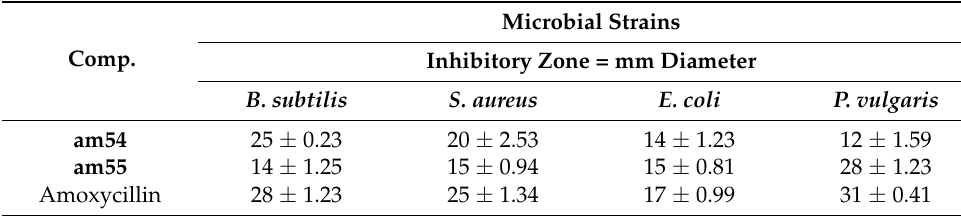
Table 25. Antimicrobial screening results of the compounds ( am54 – am55 ).